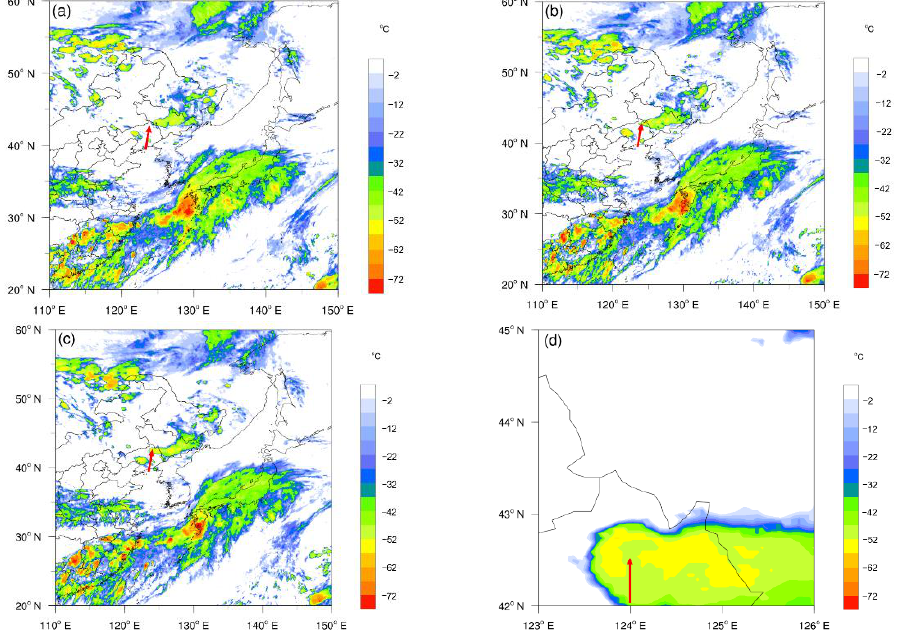
Figure 3. The HMW-8 satellite image (TBB, unit: ◦ C) at ( a ) 16:00 LST, ( b ) 17:00 LST, and ( c ) 18:00 LST on 3 July 2019. ( d ) Enlarged view of the squall line tail in ( c ). The red arrows point to where the tornado